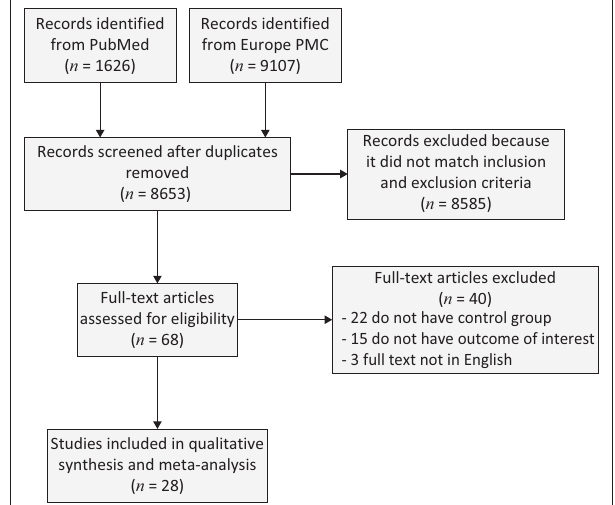
FIGURE1: PRISMA diagram of the detailed process of selection of studies for inclusion in the systematic review and